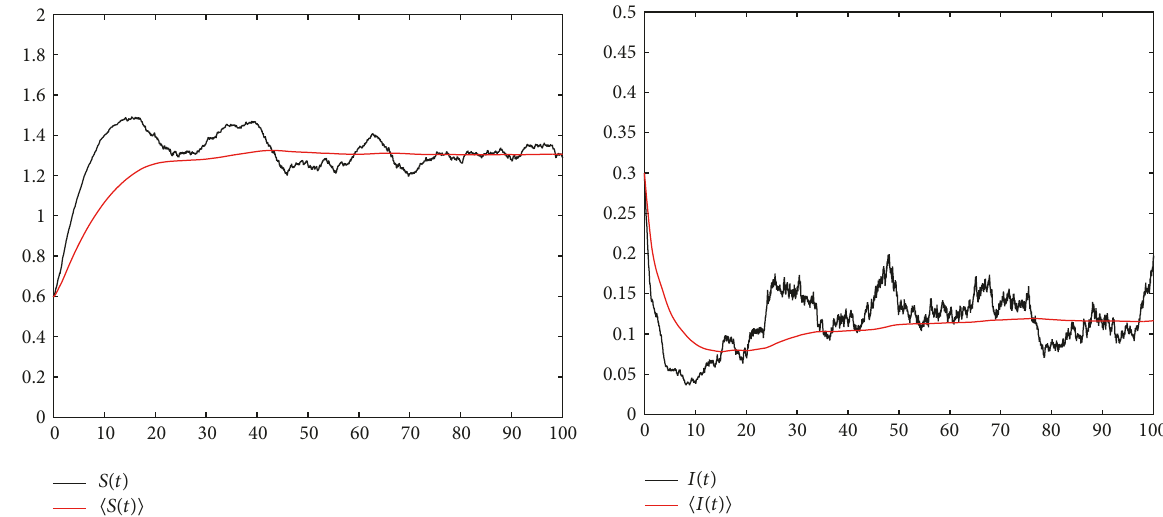
Figure 2: Computing simulation of the paths (𝑆(𝑡),𝐼(𝑡)) for the SIRS epidemic model (6).